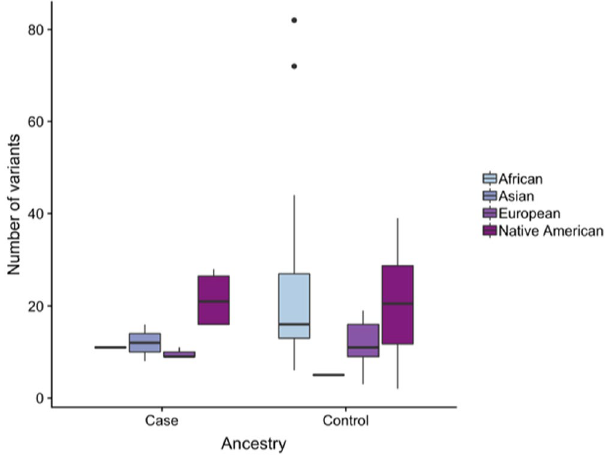
Figure 6. Number of variants in the four ancestries (African, Asian, European and Native American) of both case and control